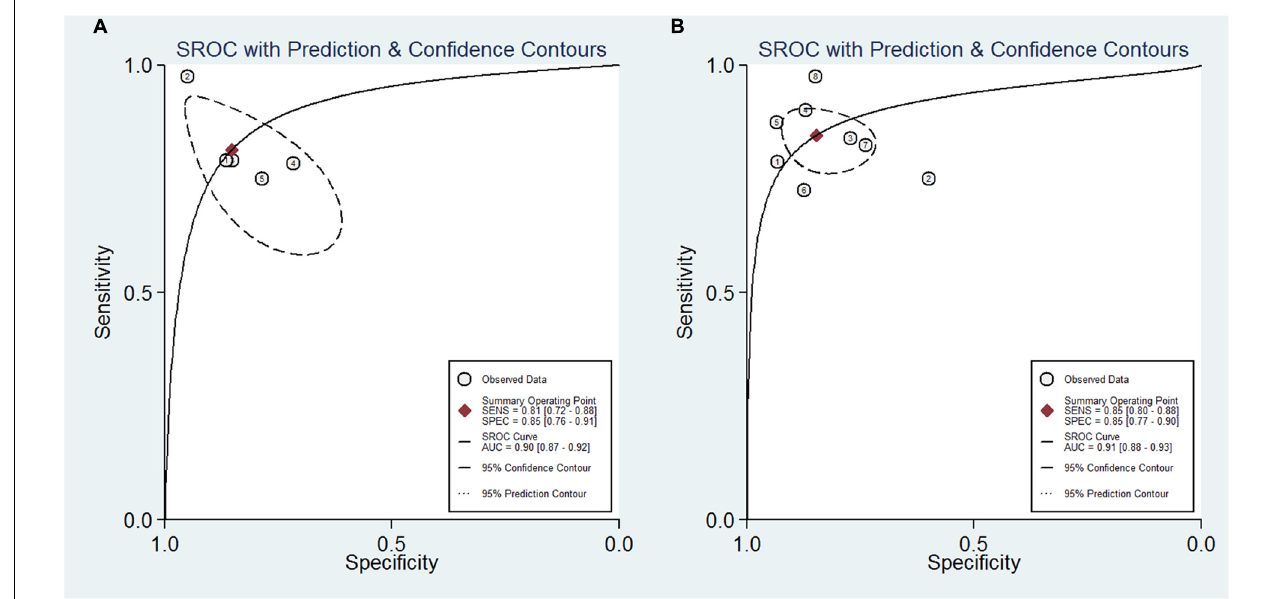
FIGURE 4 | Summary receiver operator characteristic of the accuracy of NFL (A) and pNFH (B) in the diagnosis of MND.